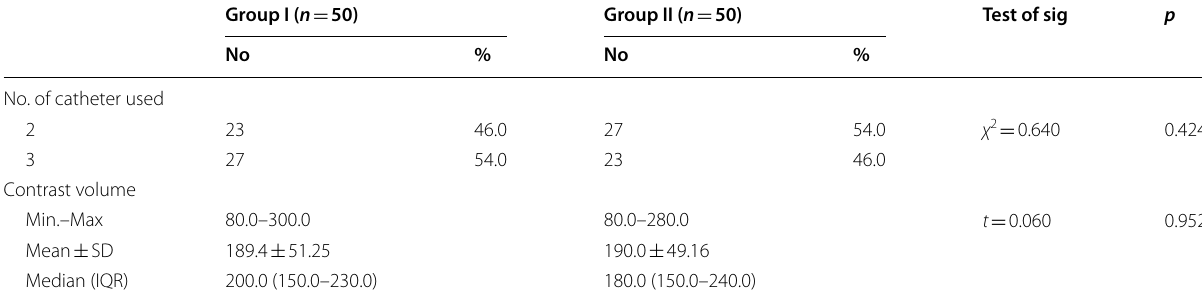
Table 7 Comparison between the two studied groups according to no. of catheter used and contrast volume